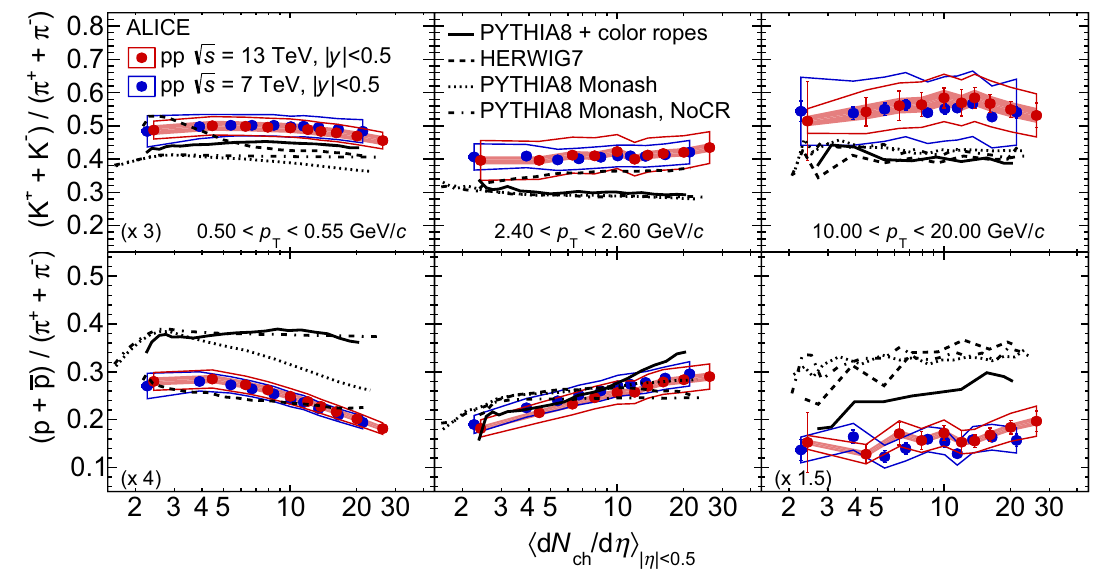
Fig. 2 Multiplicity dependence of p T -differential K/ π (upper panels) open, and shaded bands represent statistical, total systematic, and mul- √ s = 7 TeV tiplicity uncorrelated systematic uncertainties, respectively. Numbers and p/ π (lower panels) ratios measured in pp collisions at in the parenthesis in different panels represent different scale factors [11] and 13 TeV (blue and red, respectively). Lines represent different √ s = 13 TeV. Left to for data and MC predictions for better readability MC generator predictions for pp collisions at right: low-, intermediate-, and high-transverse momenta. Vertical bars,